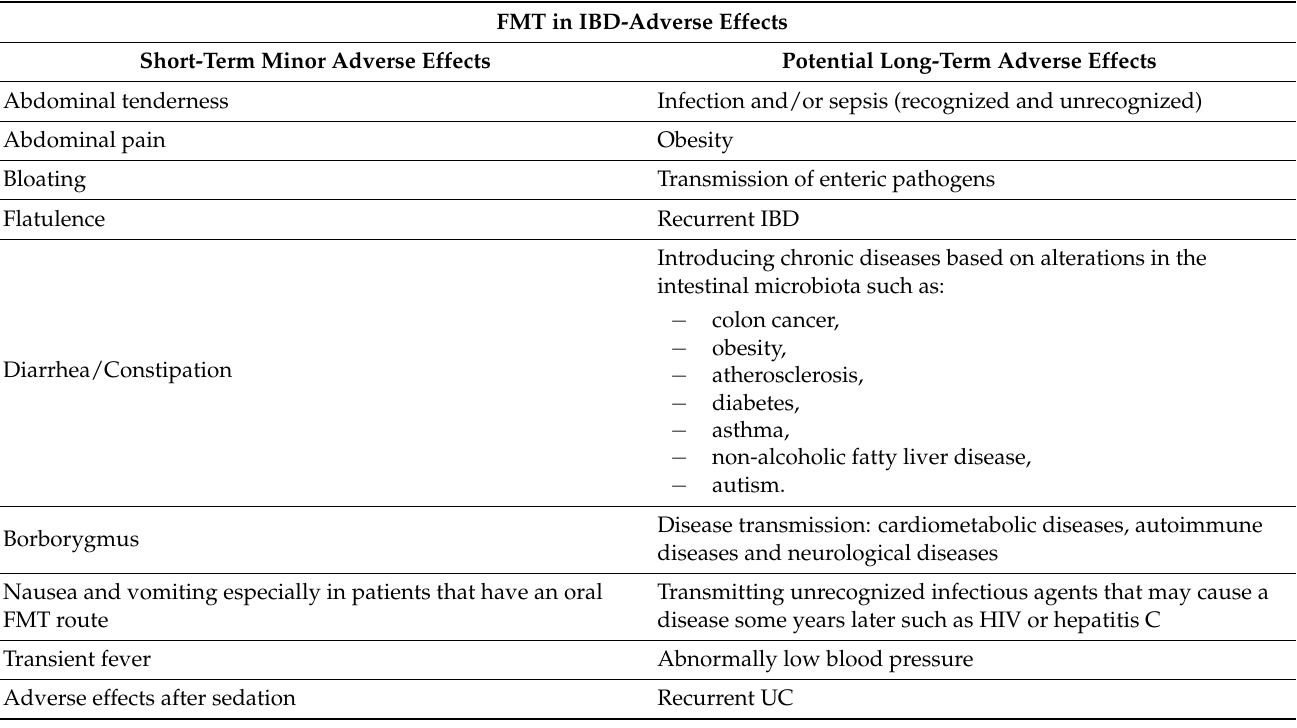
Table 3. Adverse effects of FMT in IBD